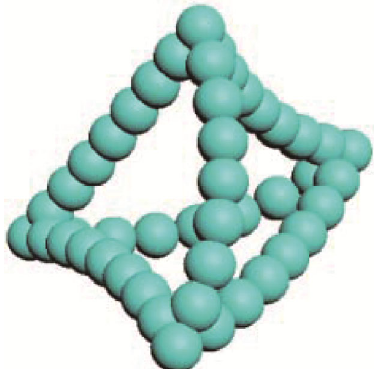
Fig. 10 Additional interpretation of geometric model. phase between particles can cause the particle